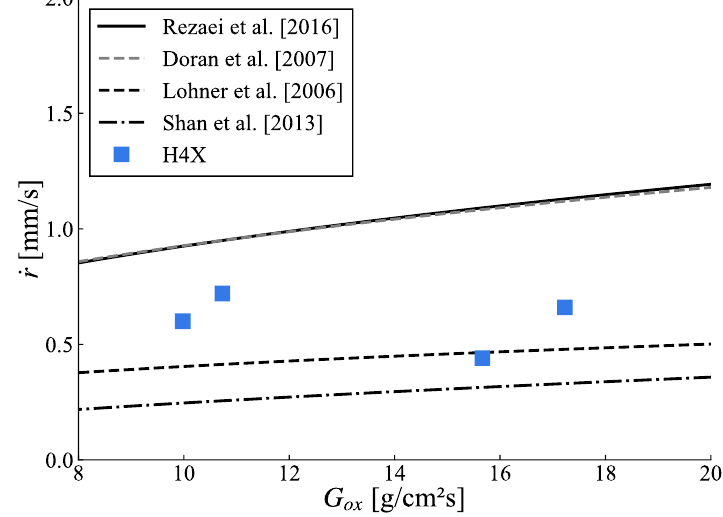
Figure 8. Comparison of fuel grain regression rates with literature data